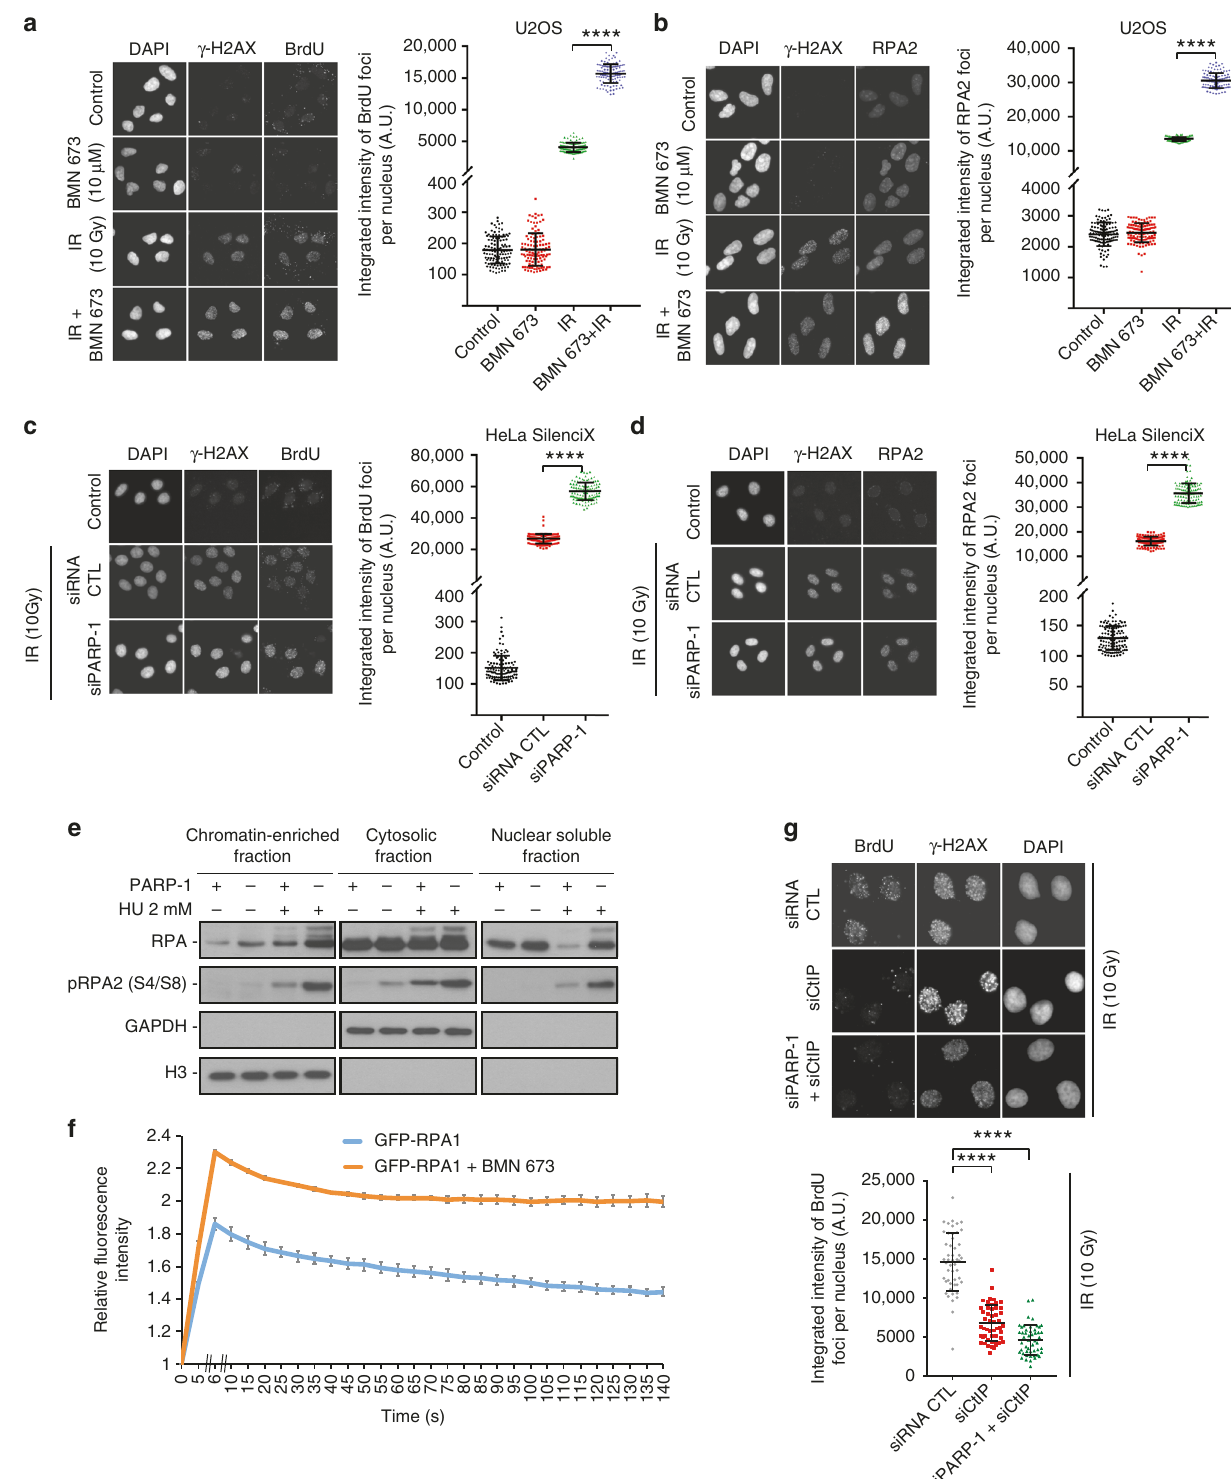
of substrate DNA. Arrays of DNA molecules (48.5 kb, derived from λ -phage) were assembled on the surface of a micro fl uidic fl owcell coated with a surface-passivating fl uid lipid bilayer 43 . The DNA substrate was linked to the bilayer via a biotin – streptavidin linkage. Fluorescently labeled PARP-1 was injected into the fl owcell and visualized using total internal re fl ection fl uorescence microscopy on thousands of DNA molecules for